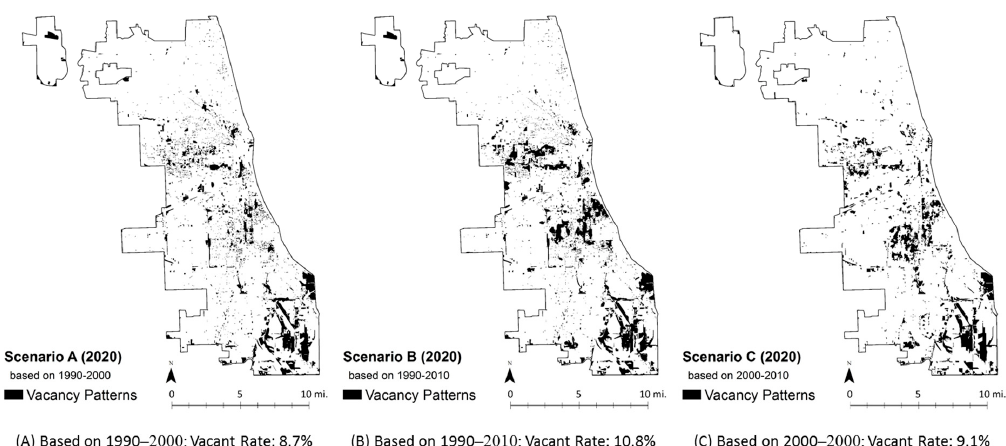
Figure 5. Possible scenarios of vacancy by 2020 based on ( A ) 1990 – 2000, ( B ) 1990 – 2010 and ( C ) 2000 – 2010.